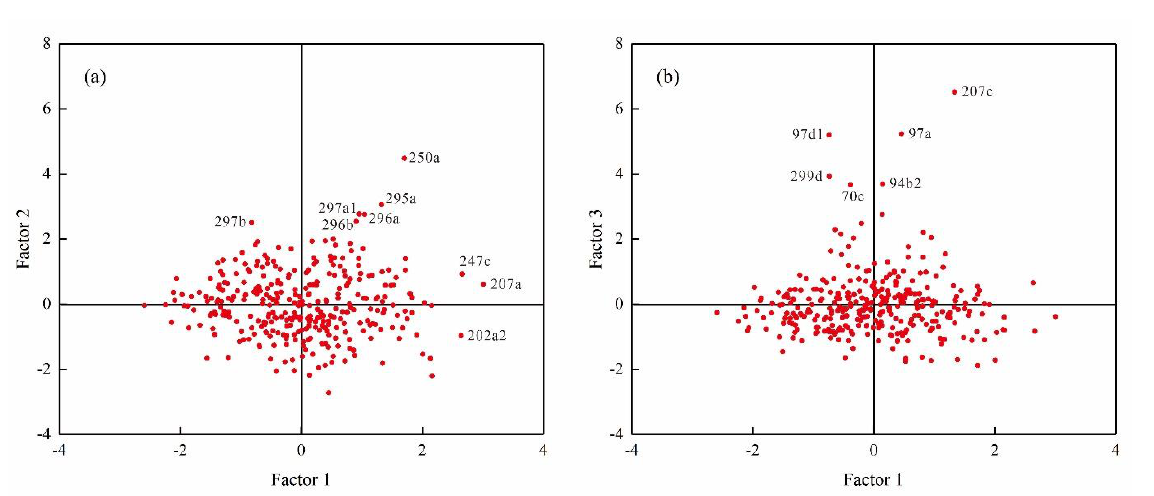
Figure 3. Scatter diagram of FA: ( a ) Factor 1 vs. Factor 2; ( b ) Factor 1 vs. Factor 3.